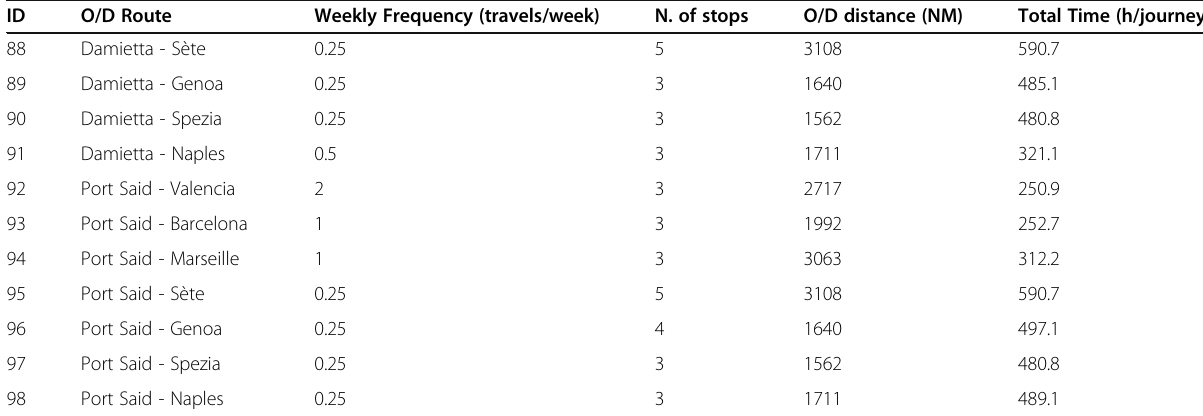
Table 19 General features of the existing network